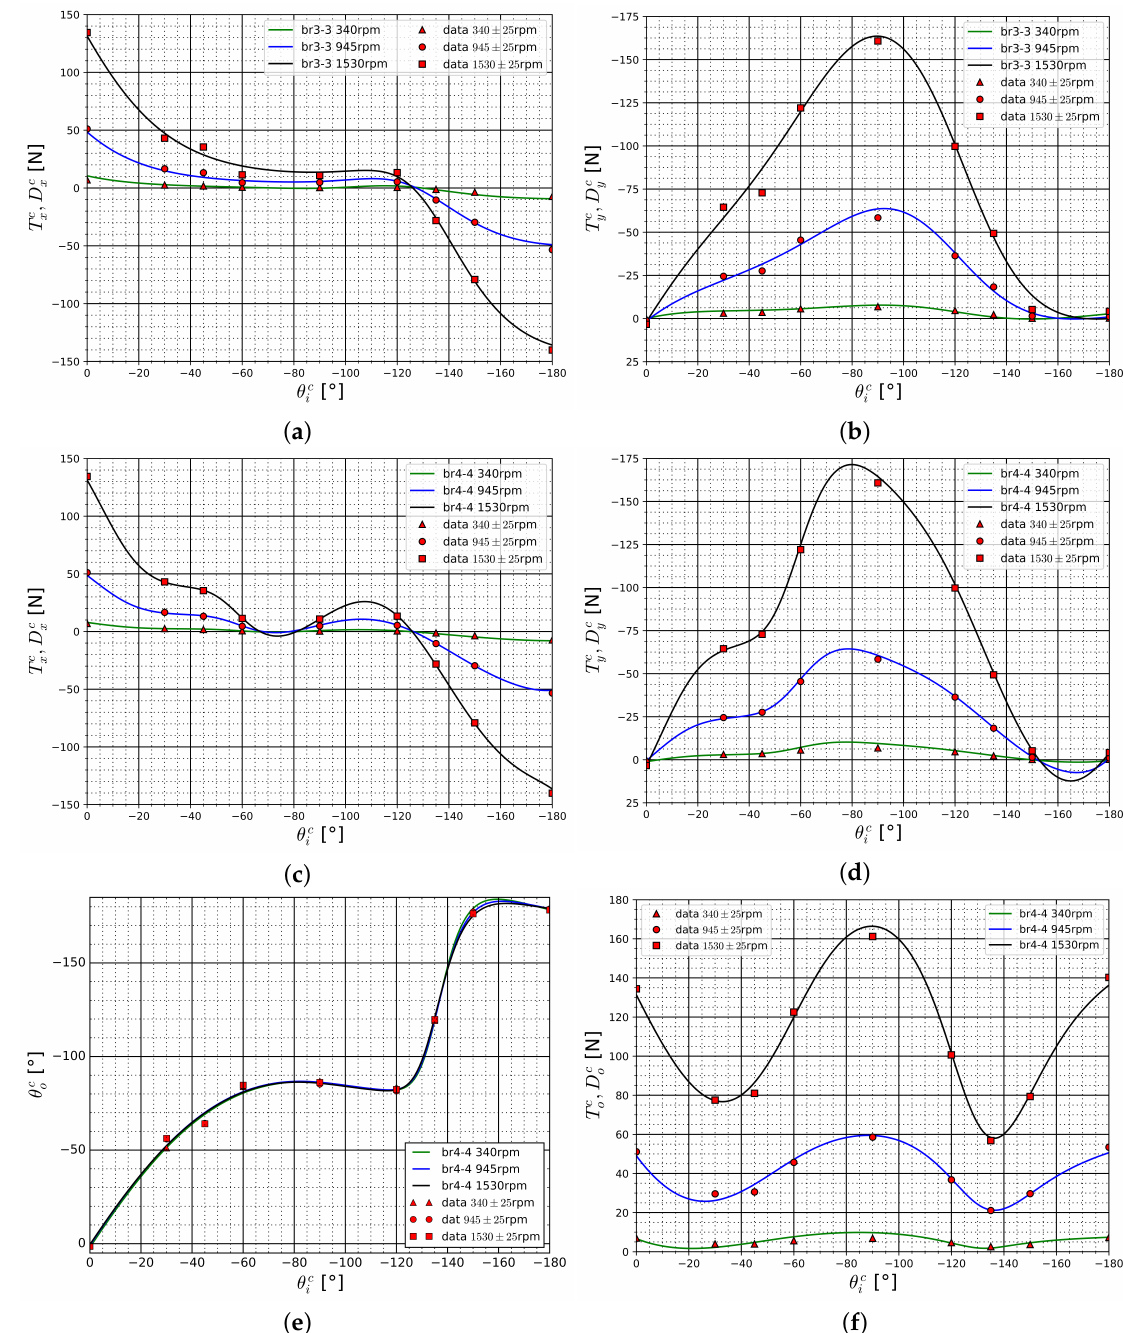
Figure 13. Identification results multilayer feedforward neural networks for the four-channel thruster. First, for case (i), the identified T c x in ( a ) and T c y in ( b ) with respective residuals 301.59 and 514.55. Second, for case (ii), the identified T c x in ( c ) and T c y in ( d ) with a network residual of 26.42. Third, for case (iii), the identified T c in ( e ) and θ c o in ( f ) with a final residual of